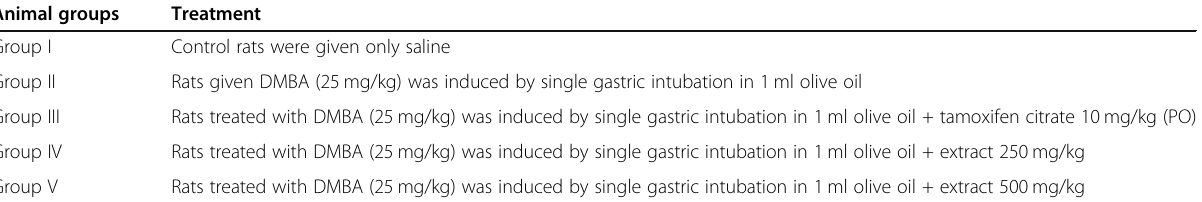
Table 1 Animal study design